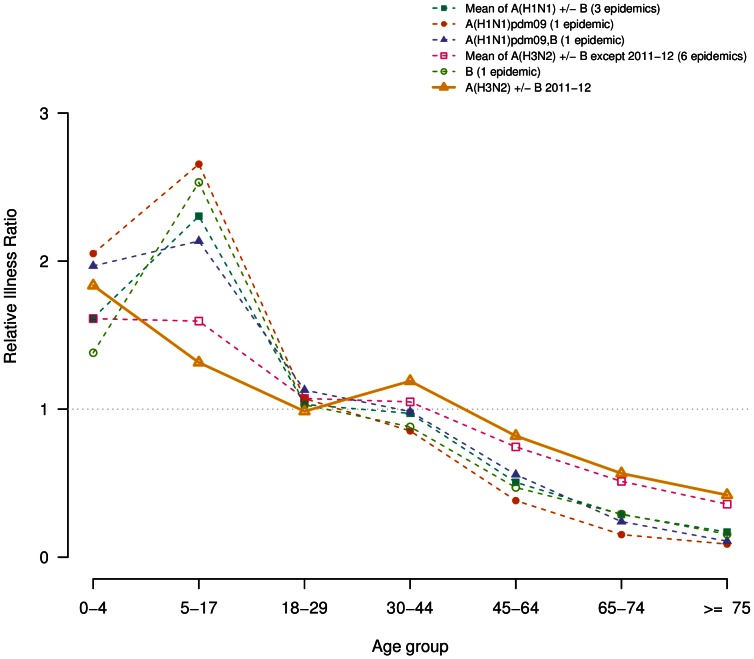
Relative Illness Ratio by age-group for the 2011/2012 epidemic (solid line) and mean of cumulated age-specific incidence by viral dominant or co-dominant subtypes for others epidemics from 1999–2000 epidemic (dashed lines).A(H1N1) and co-dominant A(H1N1),B before 2009 pandemic are grouped together). The number of epidemic included in each group is indicated between parentheses in the legend.